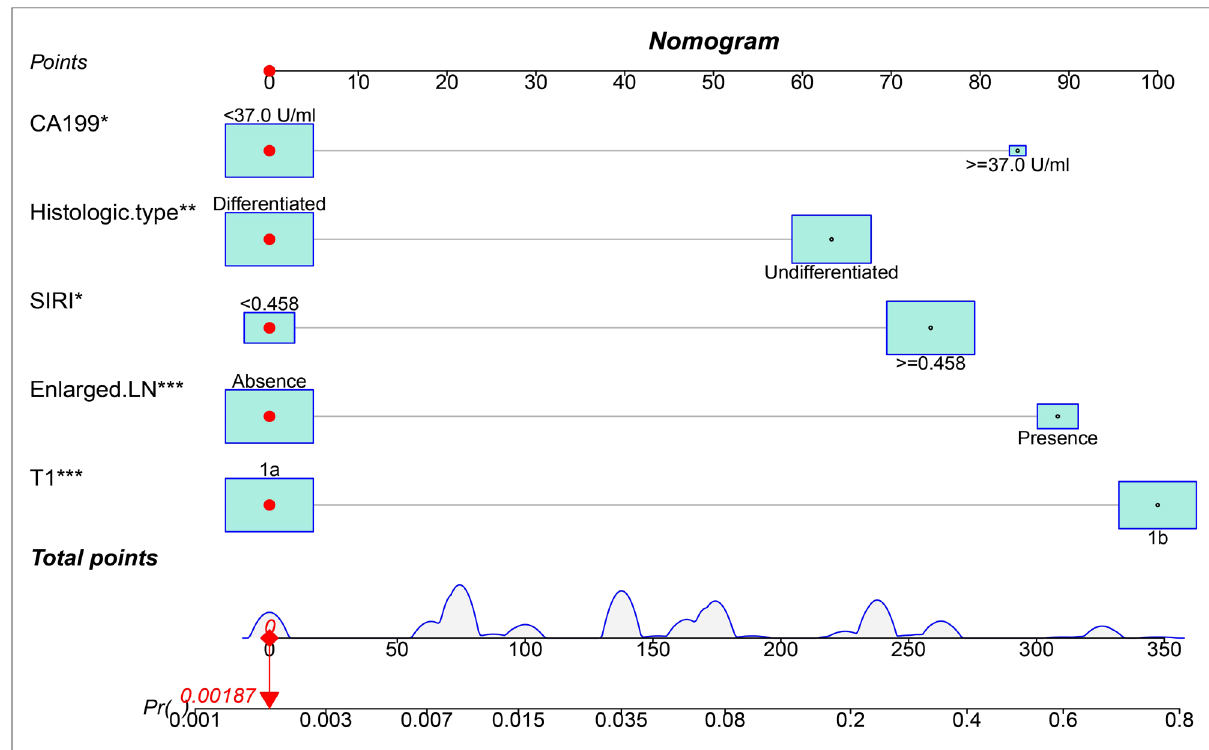
FIGURE 2 A nomogram for predicting the risk of lymph node metastasis in early gastric cancer. The scores for each variable were summed, and the total score corresponds to the probability of lymph node metastasis.